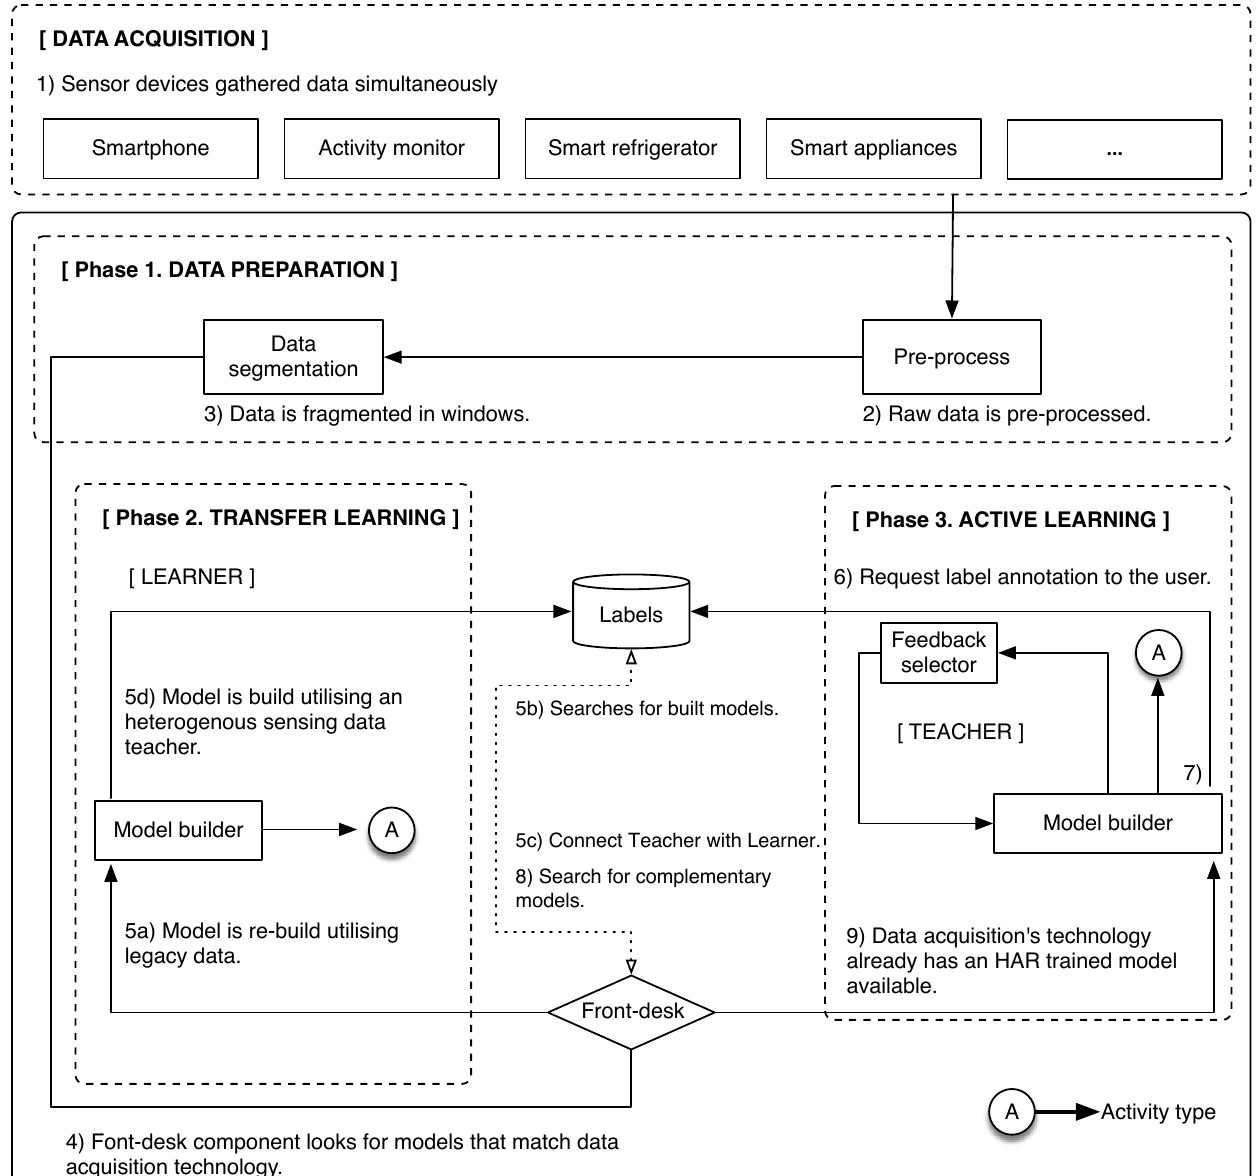
Figure 1. A high-level overview of TL-FmRADLs which combines AL phase as a mechanism of self-training, where the digits represent the sequential order of how data are